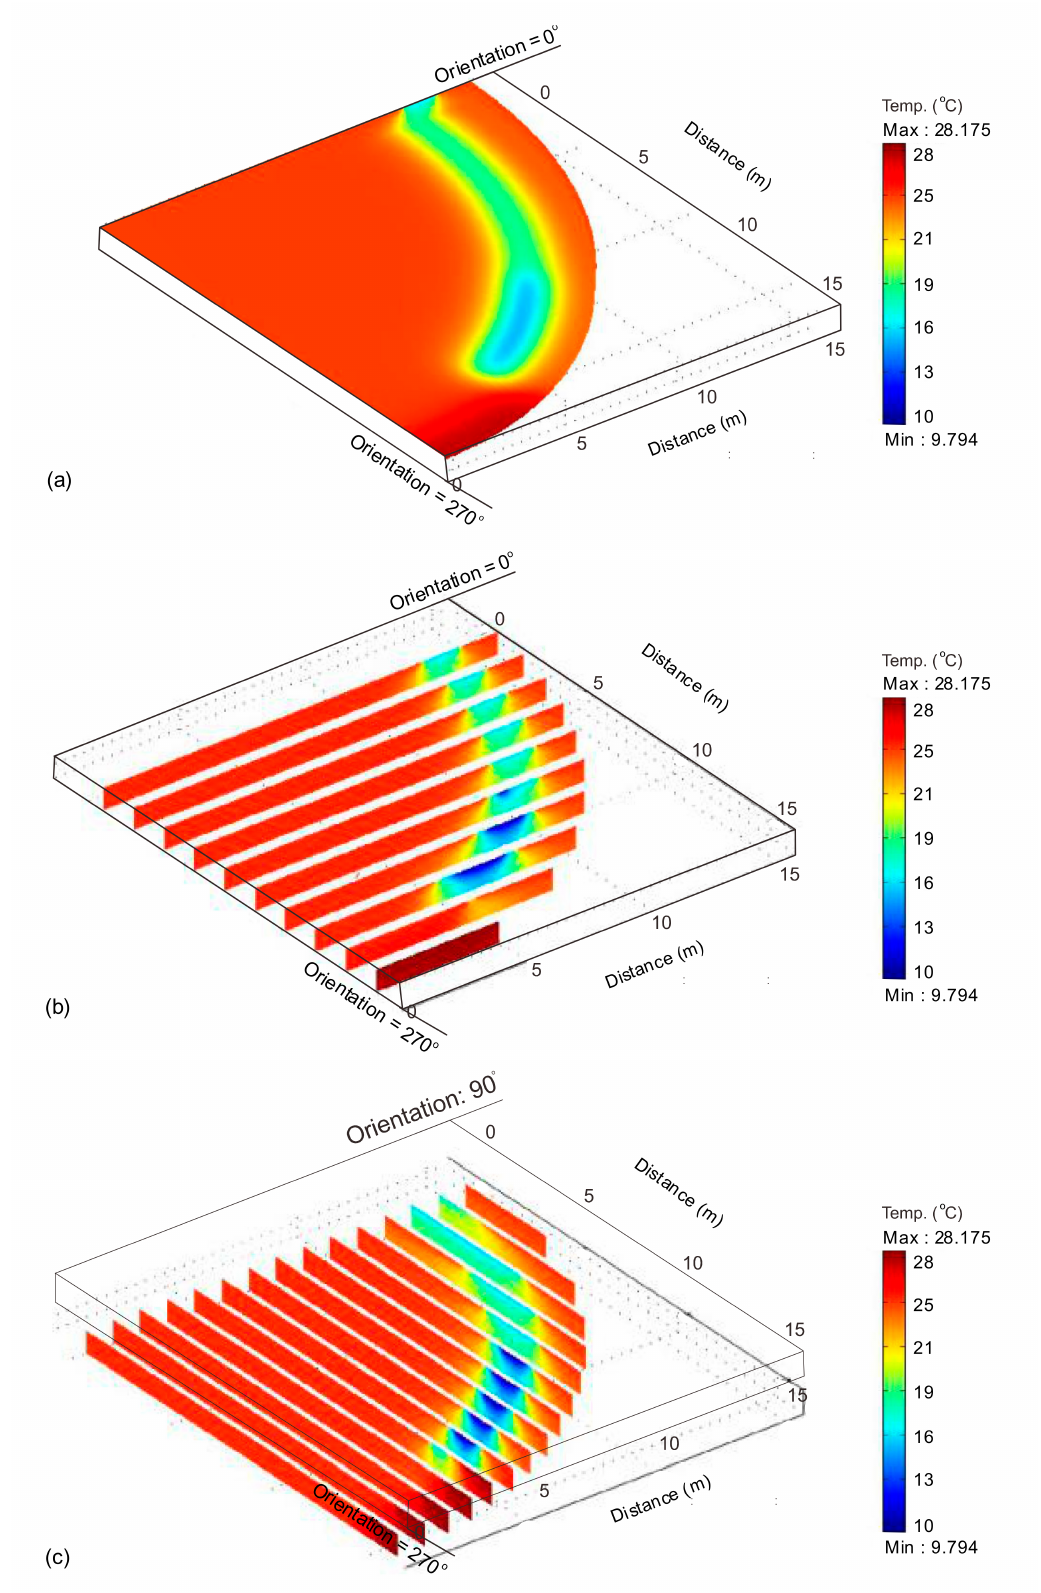
Figure 6. Temperature profile across concrete foundation; ( a ) temperatures at the top of the slab, ( b ) along orientation 0 ◦ , and ( c ) along orientation 270 ◦